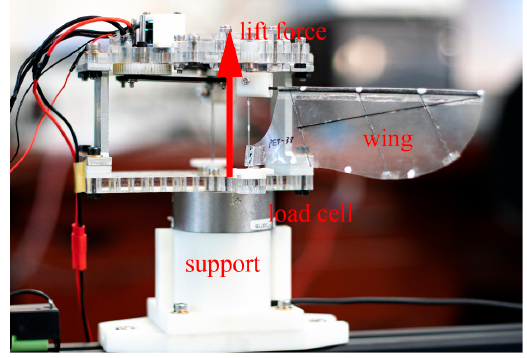
Figure 4. Flapping wing mechanism attached to the support.